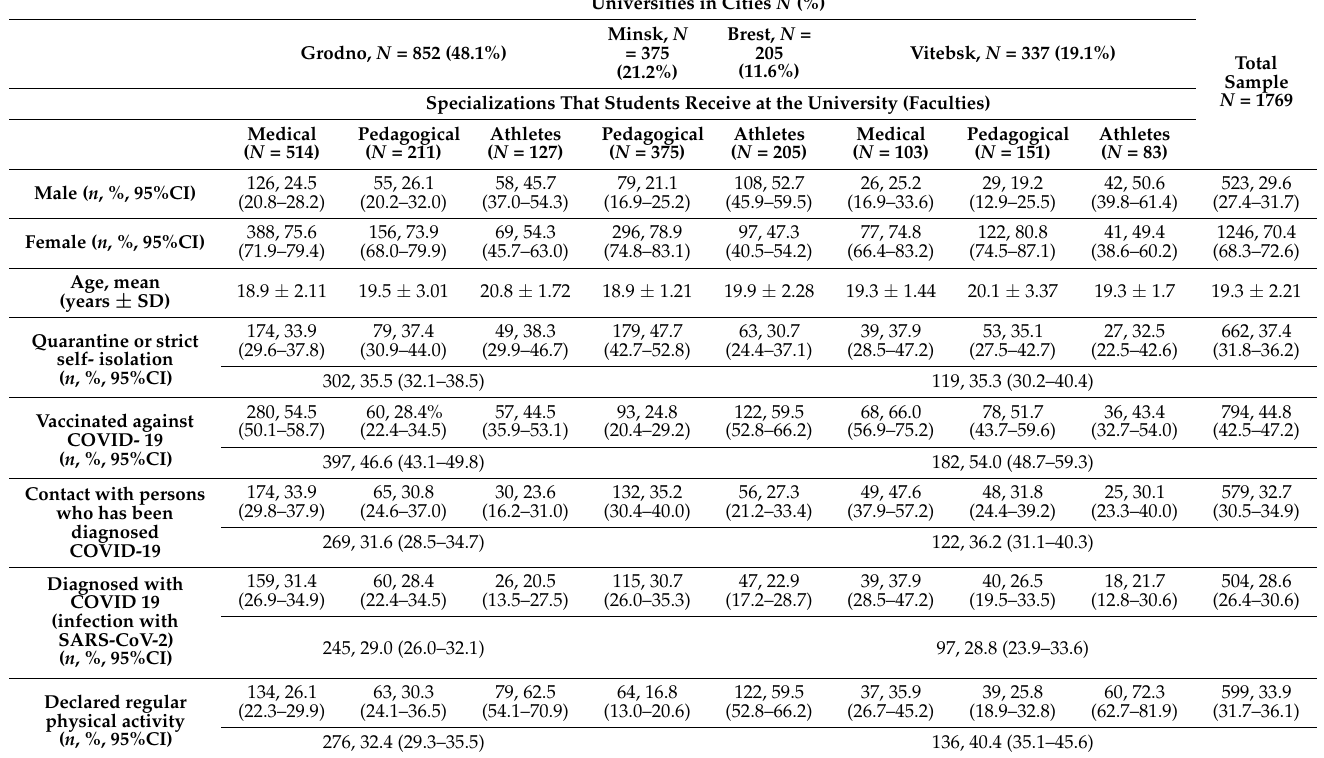
Table 1. Characteristics of the study population.